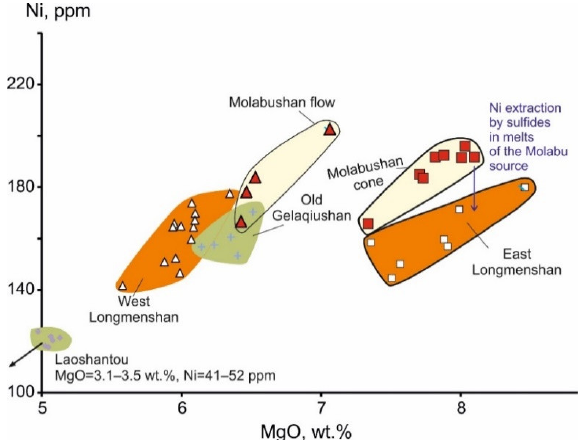
Figure 13. S versus Ni/Co ( a , c ) and Ni/MgO ( b , d ) diagrams. Symbols are as in Figure 5.